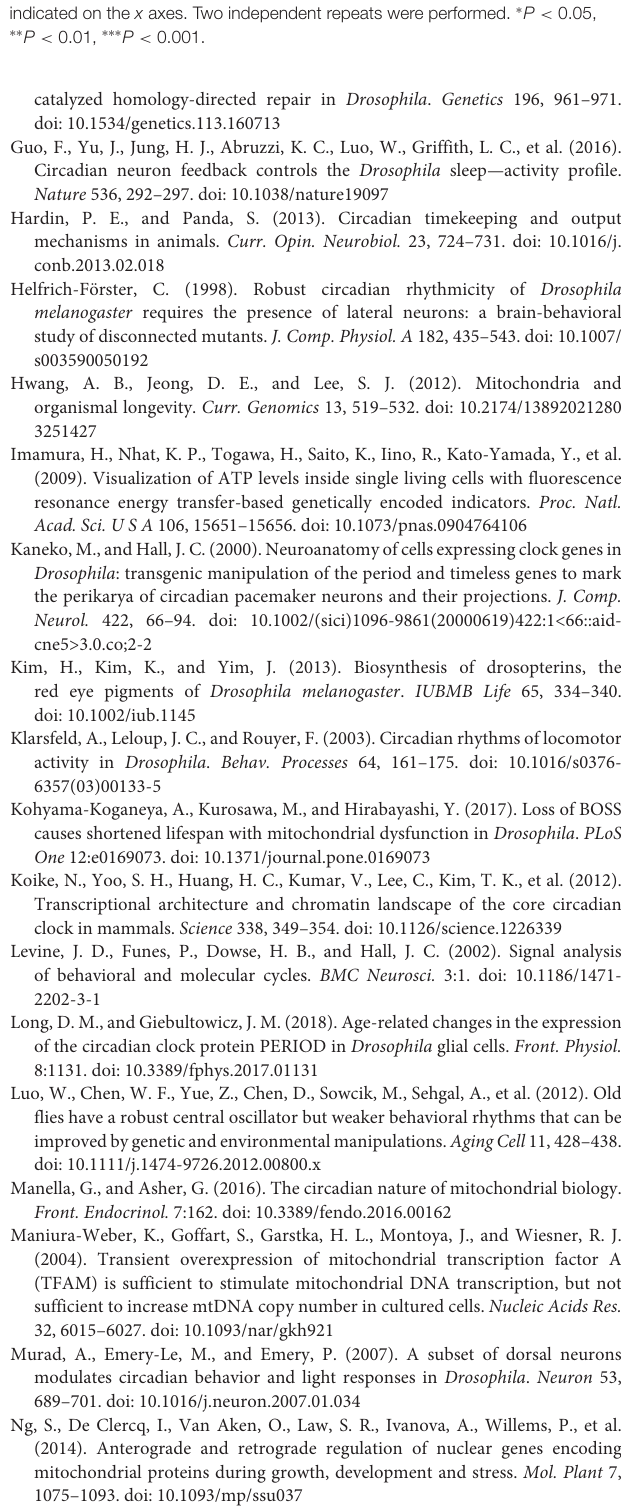
GMR > pn -RNAi flies. (C) Averaged activity profiles and actograms of control flies and repo > pn -RNAi flies. (D) Amplitudes of circadian rhythms in control flies and repo > pn -RNAi flies. n.s. no significance. White bars represent day, black bars represent night, Zeitgeber time (ZT) is indicated on the x axes. The dots above the bars indicate standard errors of the means (SEM). The amplitudes are shown as means ± SEM ( n = 40–45). Three independent repeats were performed. n.s. no significance.